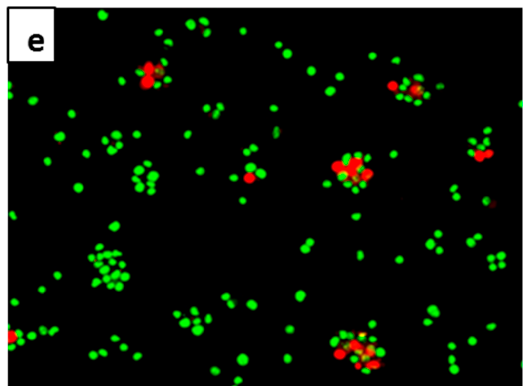
Figure 6. Florescence images of differentiated SH-SY5Y cells stained with acridine orange and propidium iodide (AO/PI) dyes. ( a ) Cells exposed to H 2 O 2 for 4 h. ( b ) Untreated cells. ( c ) Cells pre-treated for 72 h with 2.08 µM 7-geranyloxycinnamic acid. ( d ) Cells pre-treated for 72 h with 2.08 µM 7-geranyloxycinnamic acid and then exposed to H 2 O 2 for 4 h. ( e ) Cells pre-treated for 72 h with 5.97 µM curcumin and then exposed to H 2 O 2 for 4 h. Magnification (×20).